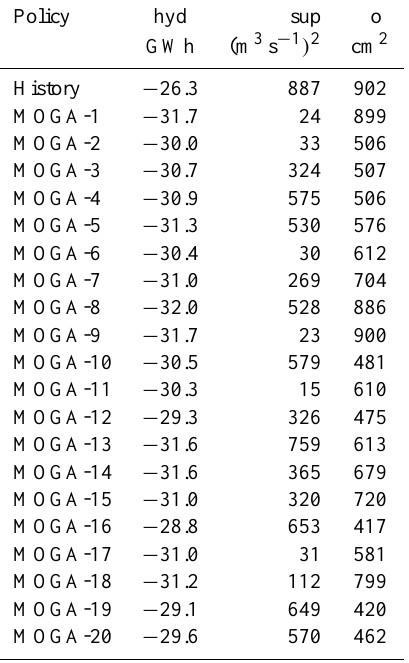
Table 2. MOGA results: average value of the immediate costs un- der different network parameterizations with 6 neurons (evaluation horizon